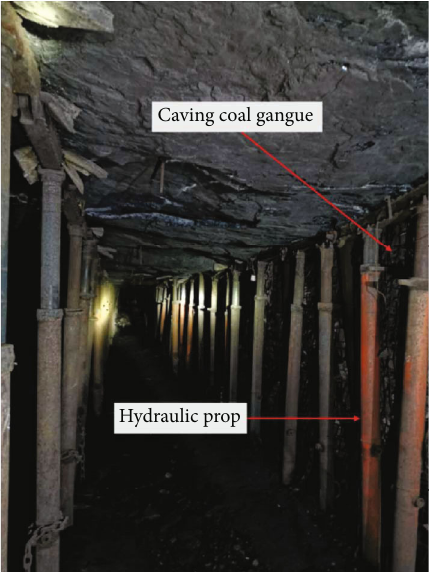
Figure 16: Renderings of gob-side